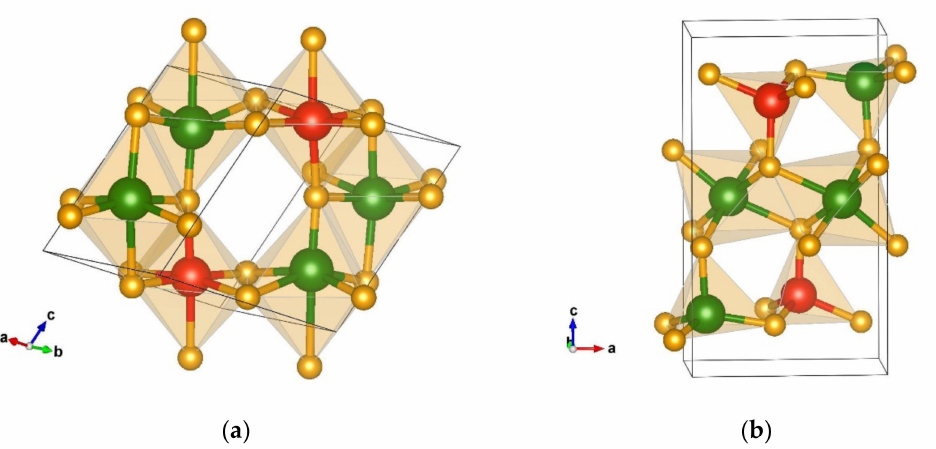
Figure 2. Visualization of favorable Cr 2 SiN 4 modifications: ( a ) δ -Cr 2 SiN 4 -type in space group P21/m (no. 11). ( b ) ε -Cr2SiN4- type in space group P21/m (no. 11). Green, red, and yellow spheres denote Cr, Si, and N atoms,